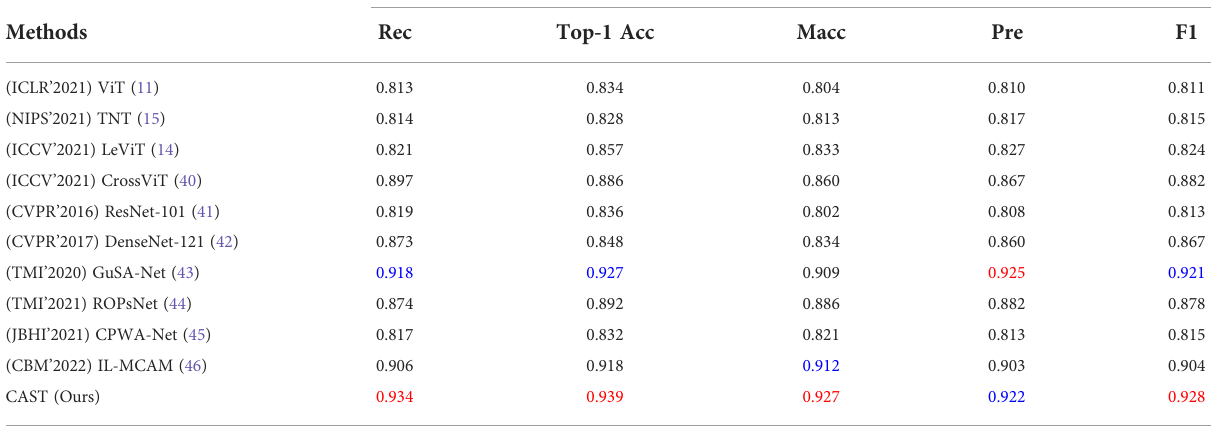
TABLE 3 Quantitative comparisons (Rec, Top-1 Acc, MAcc, Pre, and F1) for pathological information classi fi cation on the THW